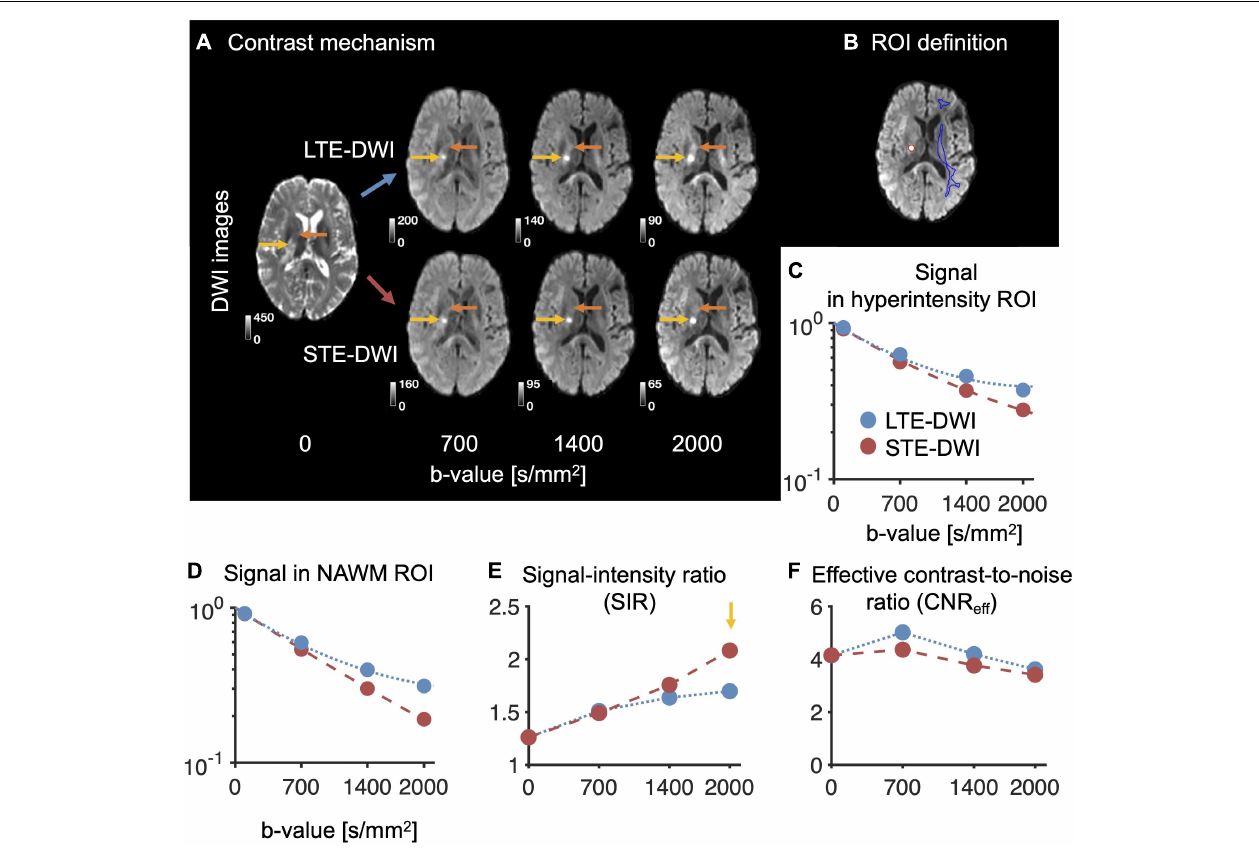
FIGURE 2 | Illustration of STE-DWI and LTE-DWI contrasts across different b -values. Panel (A) shows that the contrasts with LTE-DWI and STE-DWI are similar at low b -values, but diverge with increasing diffusion encoding strength. Already at low b -values, a hyperintense lesion is visible with both LTE-DWI and STE-DWI (yellow arrows). At higher b -values, both the lesion and nearby white matter are hyperintensed with LTE-DWI (orange arrows), but not with STE-DWI, in which the white matter is attenuated. Panel (B) shows the definition of region-of-interests (ROIs). The red region delineates ROI of a hyperintensity, whereas the blue region a normally appearing contralateral white matter (NAWM). Panels (C,D) show signal attenuations in the hyperintensity and in NAWM, respectively. The dotted blue line corresponds to LTE-DWI, while dashed red line to STE-DWI. Panel (E) shows that the ratio of the signal intensity of the hyperintensity and the NAWM (i.e., the SIR-value) increases with the b -value and reaches higher values with STE-DWI than with LTE-DWI (yellow arrow). Panel (F) shows the contrast-to-noise ratio efficiency (CNR eff ) in the hyperintensity and the NAWM. The CNR eff decreases with increasing b -values, but it is non-zero even for b -value of 0 s/mm 2 due to high T2w FLAIR signal in the tumor. This indicates that SIR may be a more intuitive quantity than CNR eff for capturing these differences in contrast. Data are from patient P1 in Figure 1